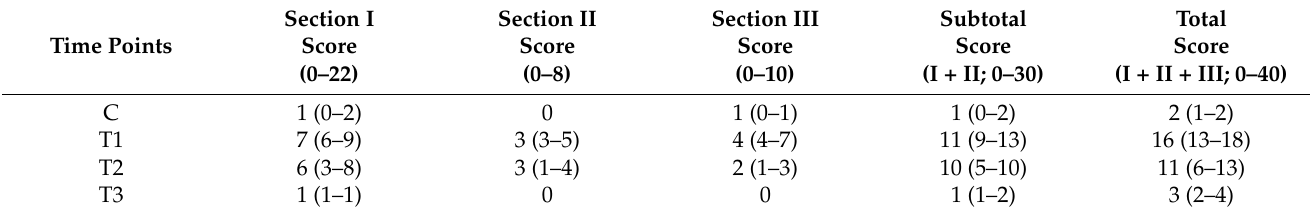
Table 6. Descriptive statistics of partial and Total scores by group and time points (Control Group at inclusion, C; Pain Group at different time points, T1 = at the inclusion in the study; T2 = after the administration of an analgesic drug; T3 = at recovery). Data are expressed as median and interquartile range (IQR).